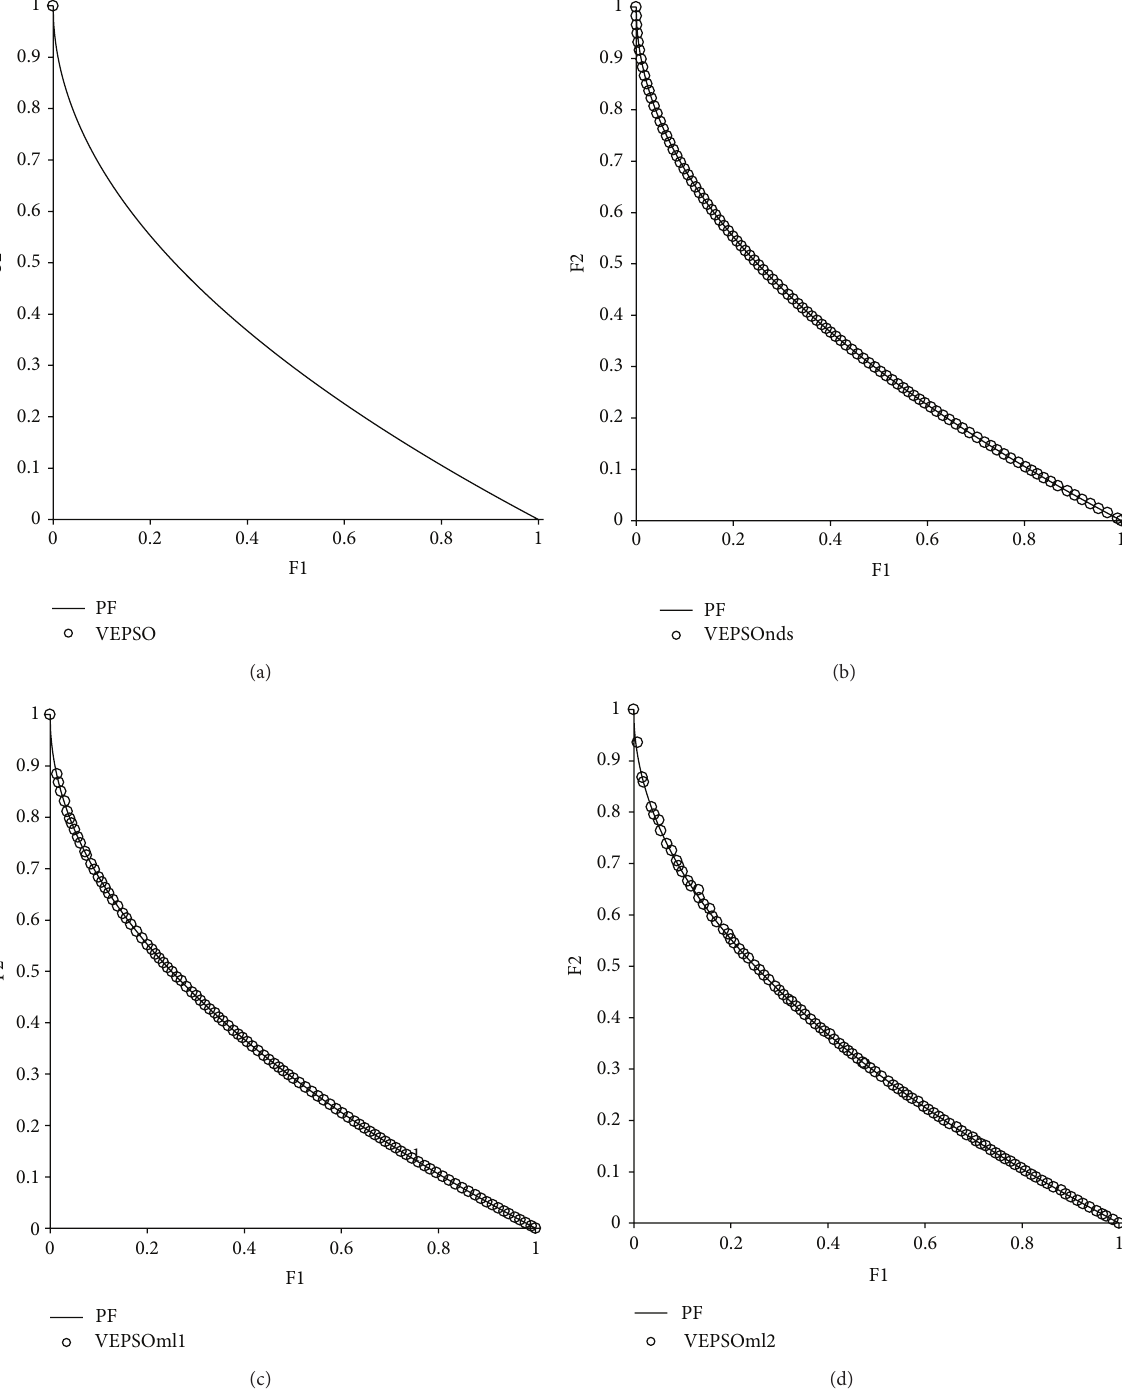
(AbYSS) [22], and the speed-constrained multiobjective PSO (SMPSO) algorithm [23]. All algorithms only computed 25000 function evaluations, and the archive size was set to 100 for fair comparison. The population size for NSGA-II was set to 100 for optimisation. The Simulated Binary Crossover